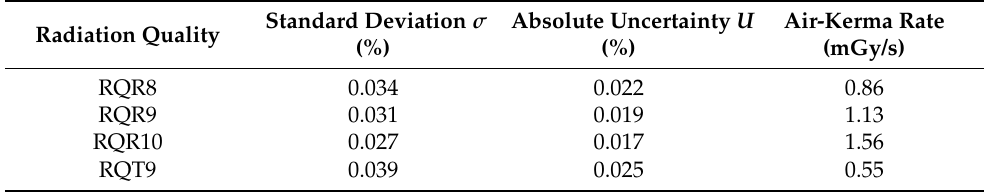
Table 2. Standard deviation and absolute uncertainty (k = 2) for IVISCAN ® repeatability measure- ments for RQR8, RQR9, RQR10, and RQT9 radiation qualities at LNHB.